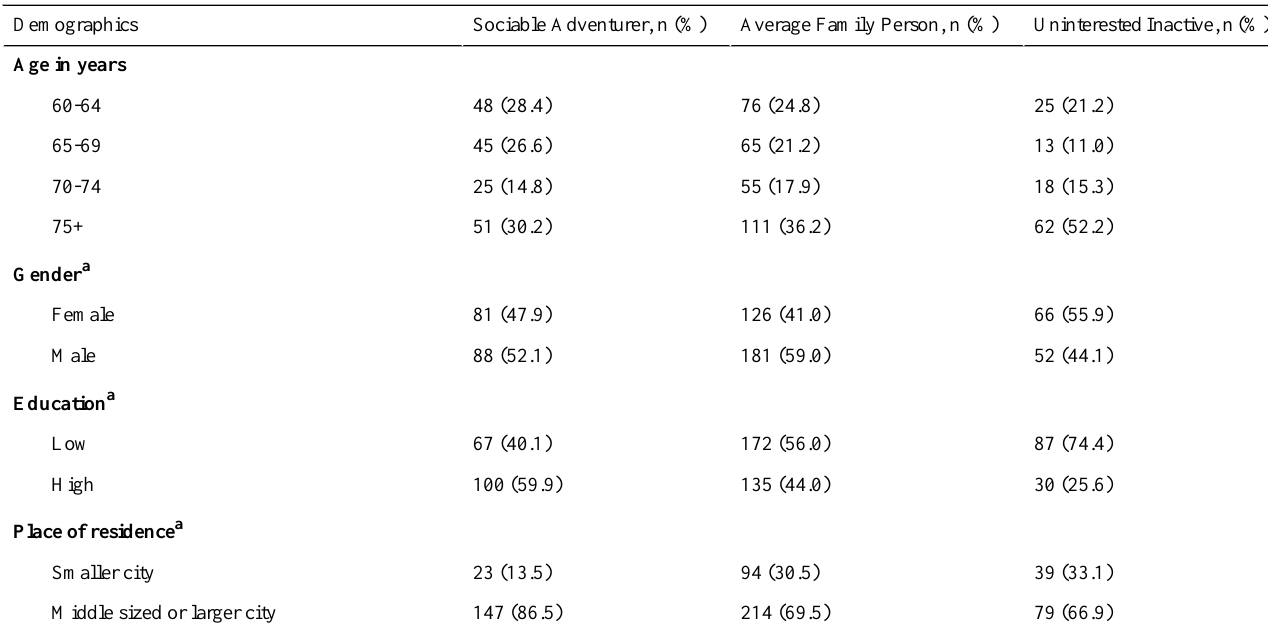
Table 3. Characteristics of clusters by demographic